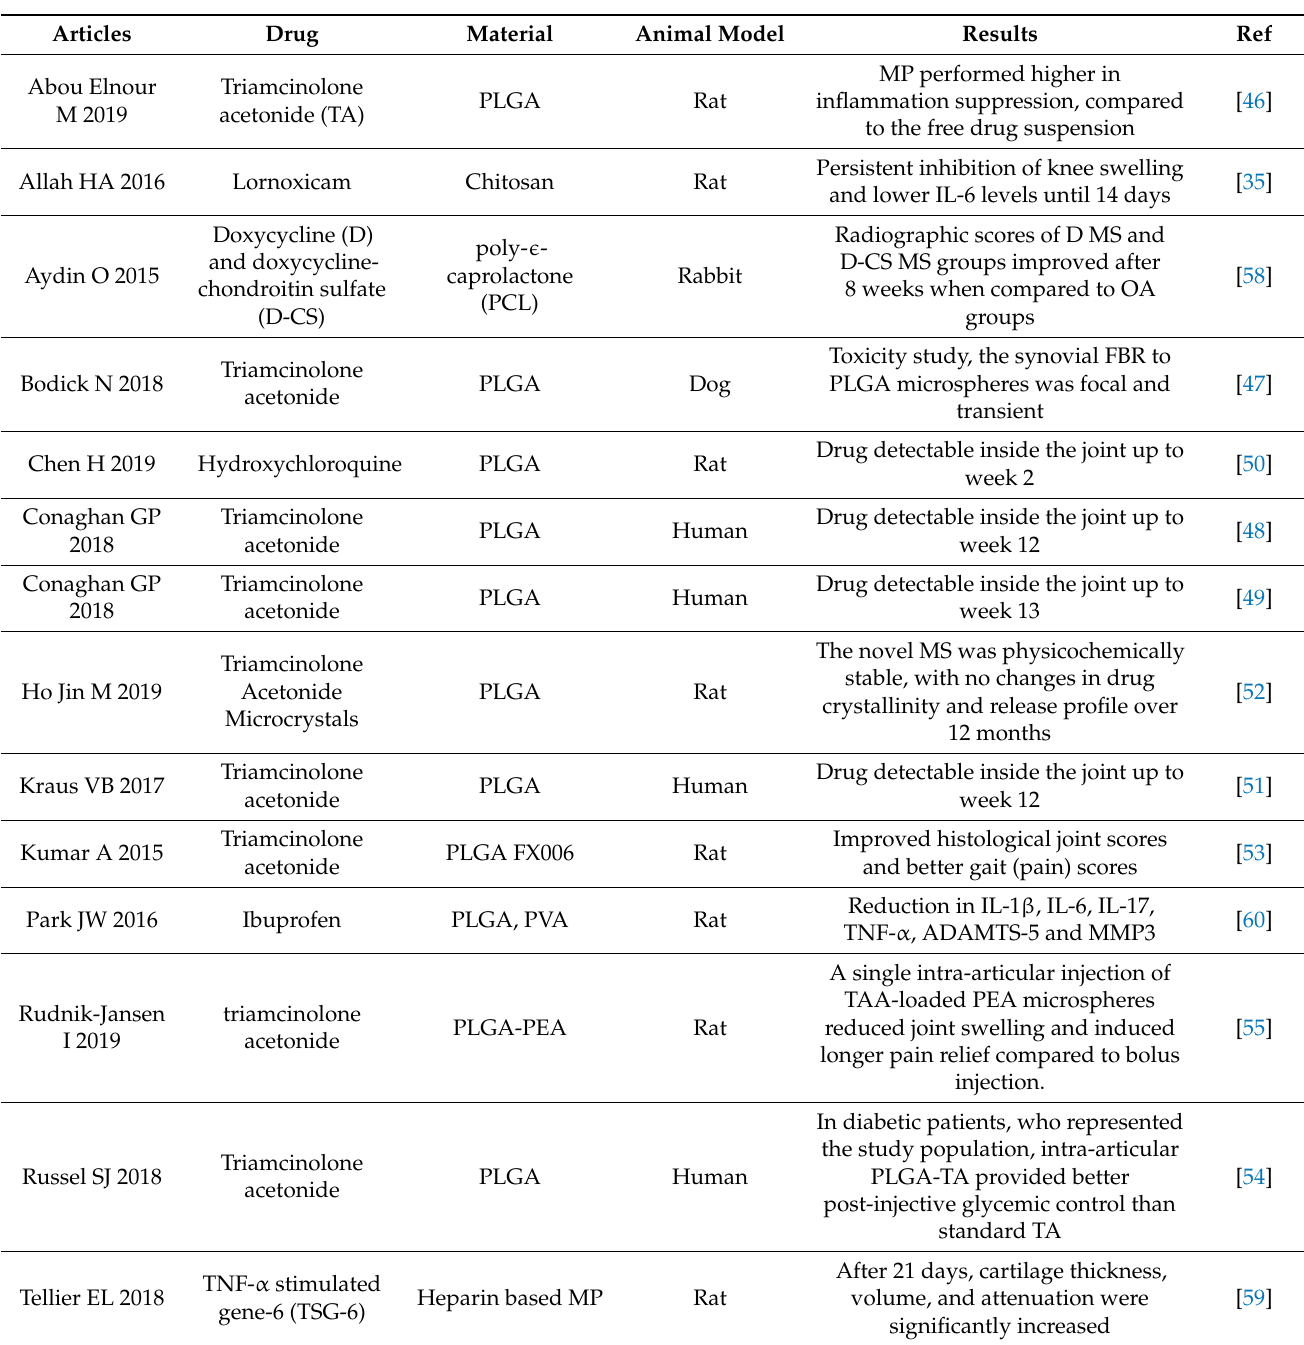
Table 2. Synopsis of studies employing microparticles (MPs). Legend: ADAMTS-5—A disintegrin and